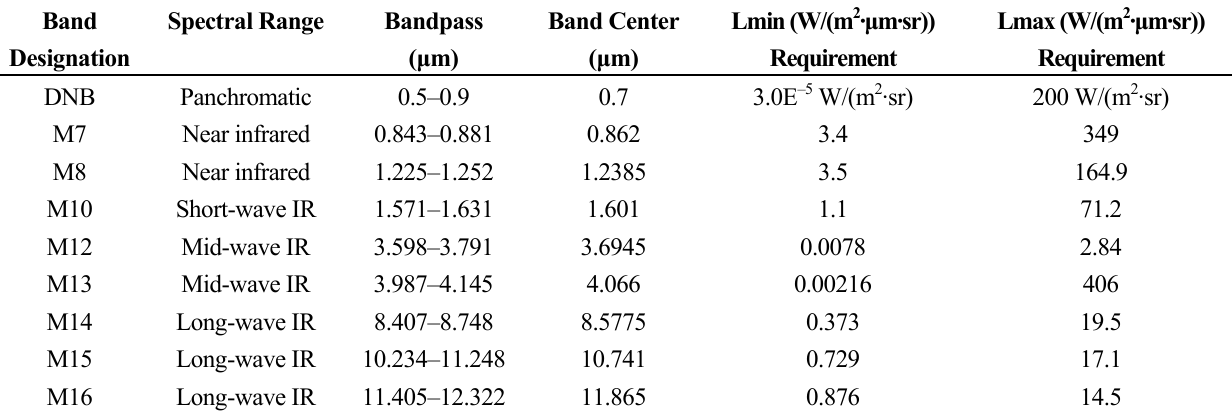
Table 1. Characteristics of the Nine Visible Infrared Imaging Radiometer Suite (VIIRS) Spectral Bands Collecting Data at Night [12]